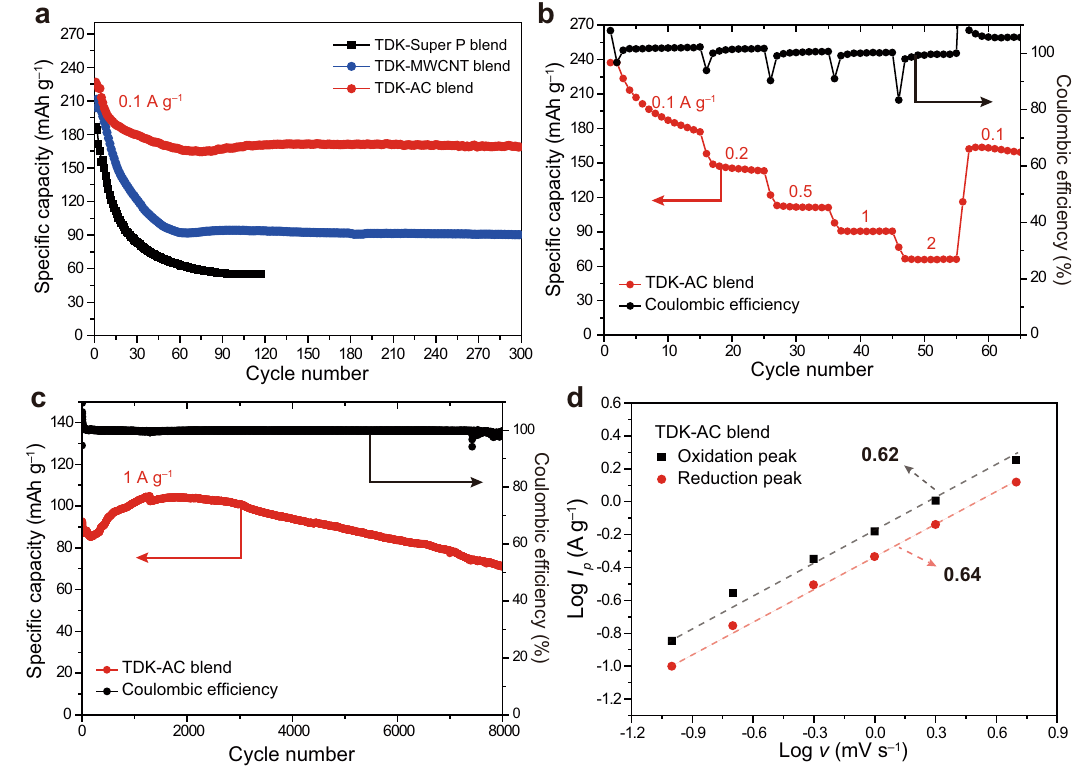
Fig. 4 Electrochemical performance of TDK. a Cycling performance of TDK with different carbon materials. b Rate capability of TDK-AC blend. c Long- term cycling performance of TDK-AC blend at a current density of 1 A g − 1 . d Log v -log I p plots to extract the b -values based on the relation I p = av b